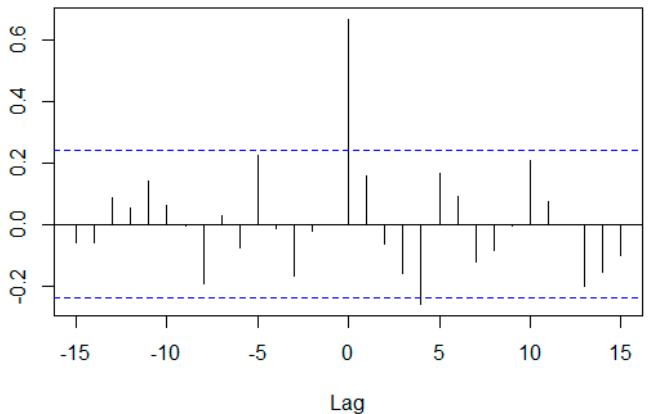
Figure 26. Cross-correlation coefficient between monthly rate of return of the whole sample group and monthly rate of return of the display group for Jan 2013–Jul 2018.